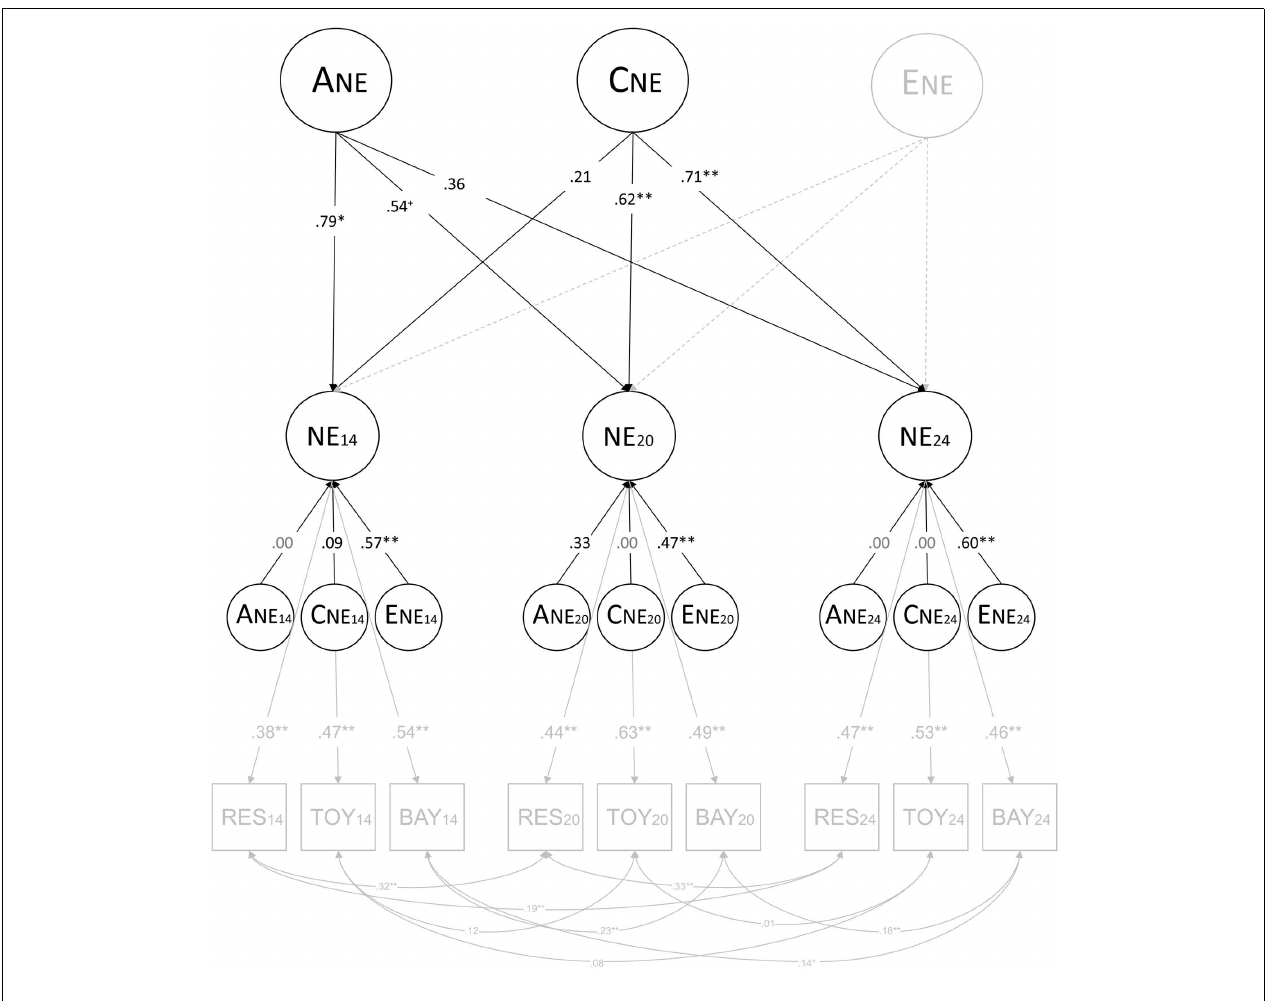
FIGURE 3 | Results of independent pathway model with no common non-shared environmental influences. A NE = common genetic influences; C NE = common shared environmental influences; E NE = common non-shared environmental influences; A NE14 , A NE20 , and A NE24 = genetic influences specific to 14, 20, and 24months; C NE14 , C NE20 , and C NE24 = shared environmental influences specific to 14, 20, and 24months; E NE14 , E NE20 , and E NE24 = non-shared influences specific